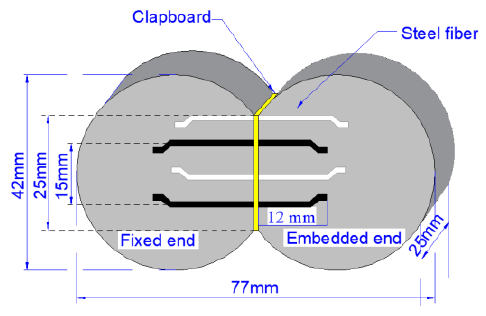
Figure 2. Pull-out specimen